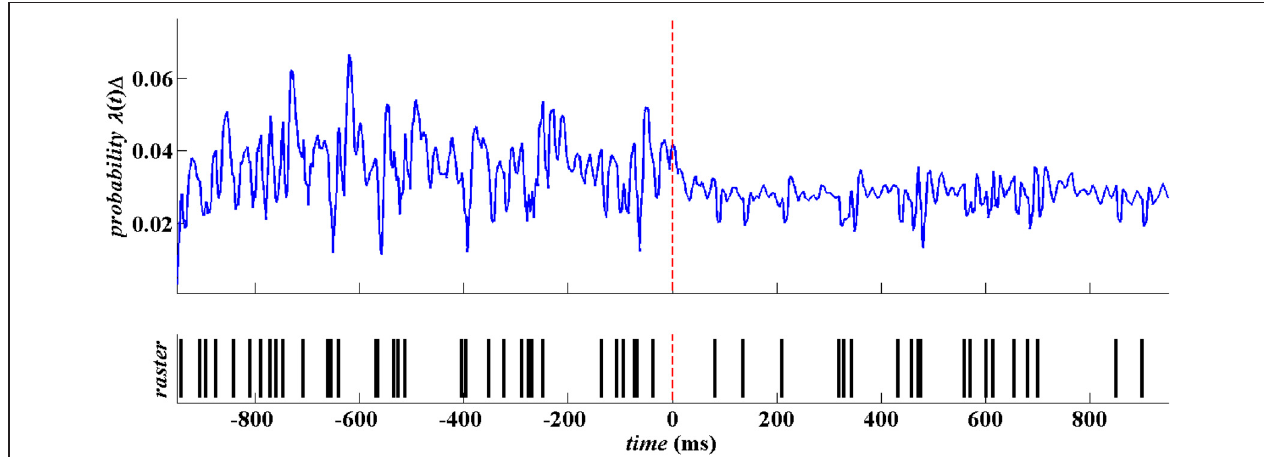
FIGURE 4 | Raw spike train data from a single STN neuron in PD patient. The spike train is in blue and the corresponding estimate of the CIF is in red.